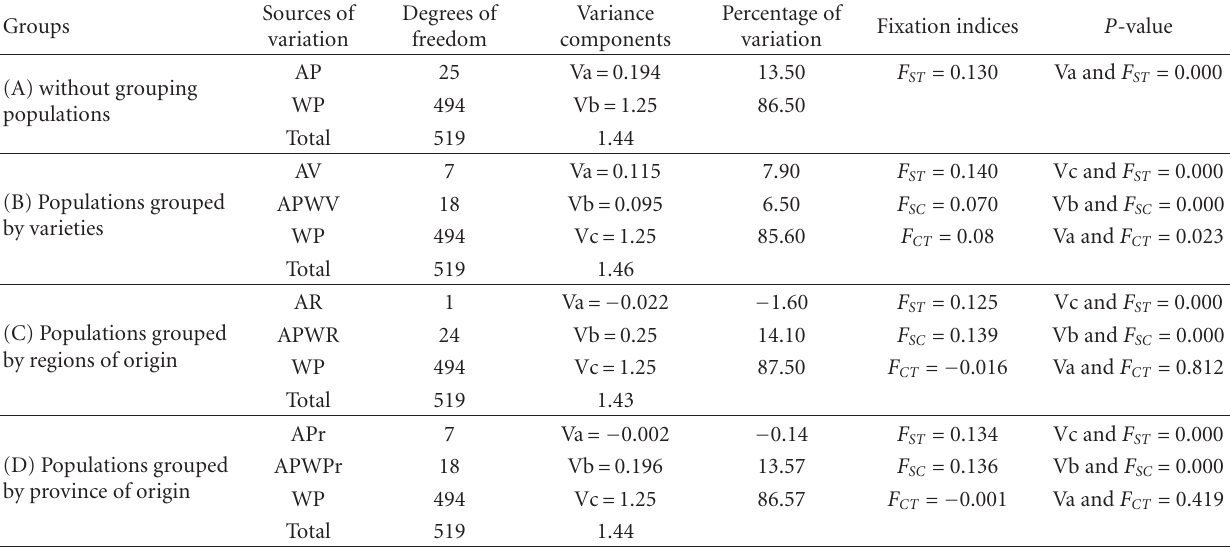
Table 4: SSR-based AMOVA for the 26 populations of arabica co ff ee: (A) without grouping the populations, (B) by grouping the populations according to varieties, (C) by grouping the populations according to regions of origin, and (D) by grouping the populations according to province of